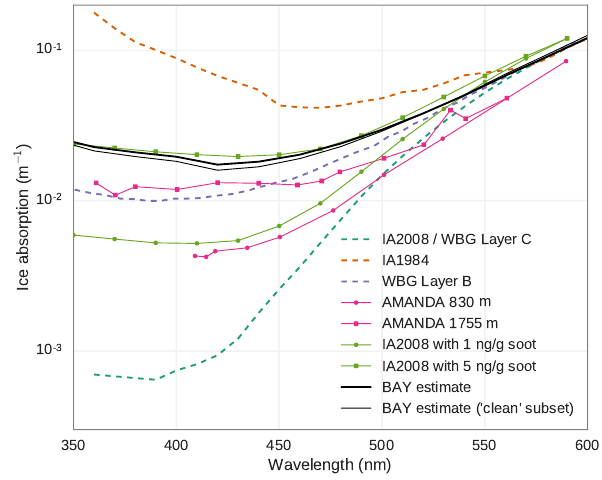
Figure 17. Estimates of ice absorption from this paper (black, BAY) from AMANDA experiment (Ackermann et al., 2006) (pink) and from Warren et al. (2006) (blue, green, maroon). Simulations (green) show absorption of snow contaminated with soot and con- sidering IA2008 for pure